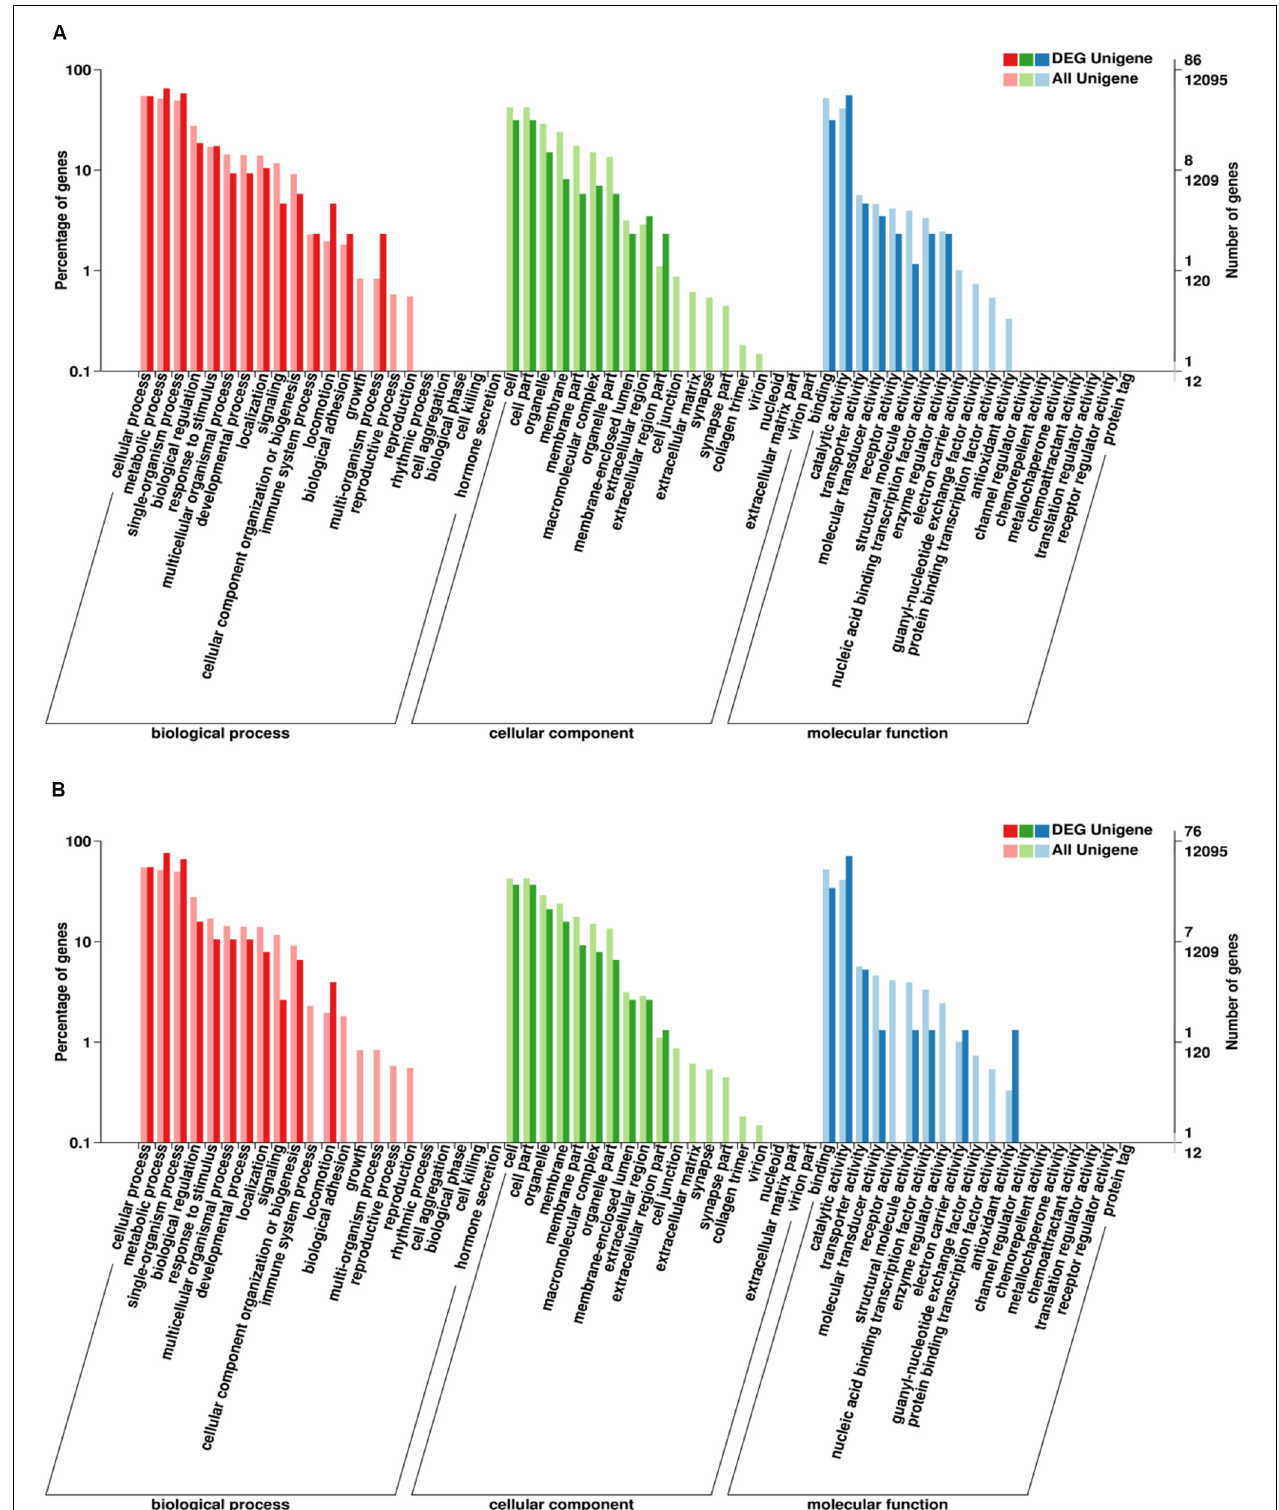
FIGURE 7 | Gene ontology (GO) classification of DEGs. X -axis: GO classification, including biological process, cellular component, and molecular function; Y -axis: The left ordinate is the percentage of the numb er of DEGs, and the right ordinate is the number of DEGs (darker bars) and the number of all genes (lighter bars) ( A , 48 h; B , 96